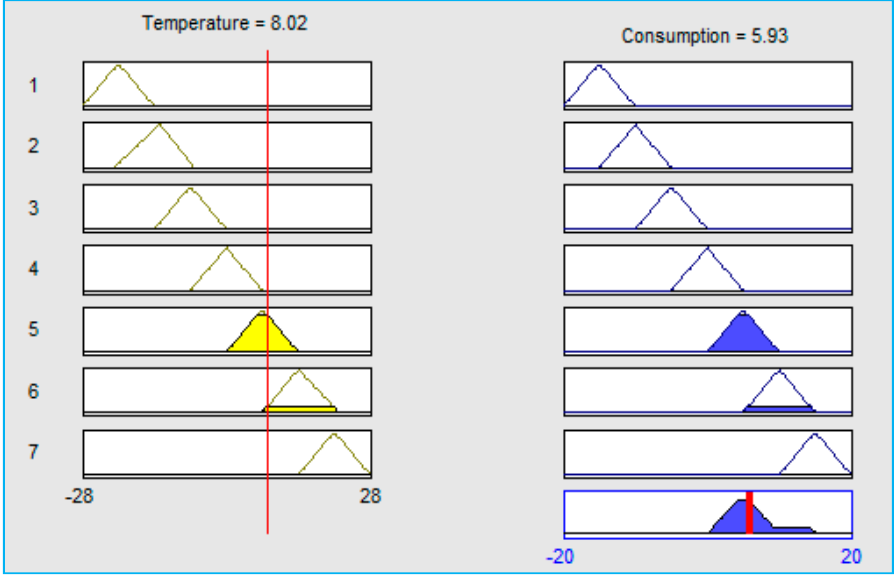
Figure 8. Example of fuzzy rule used in temperature fuzzy logic.